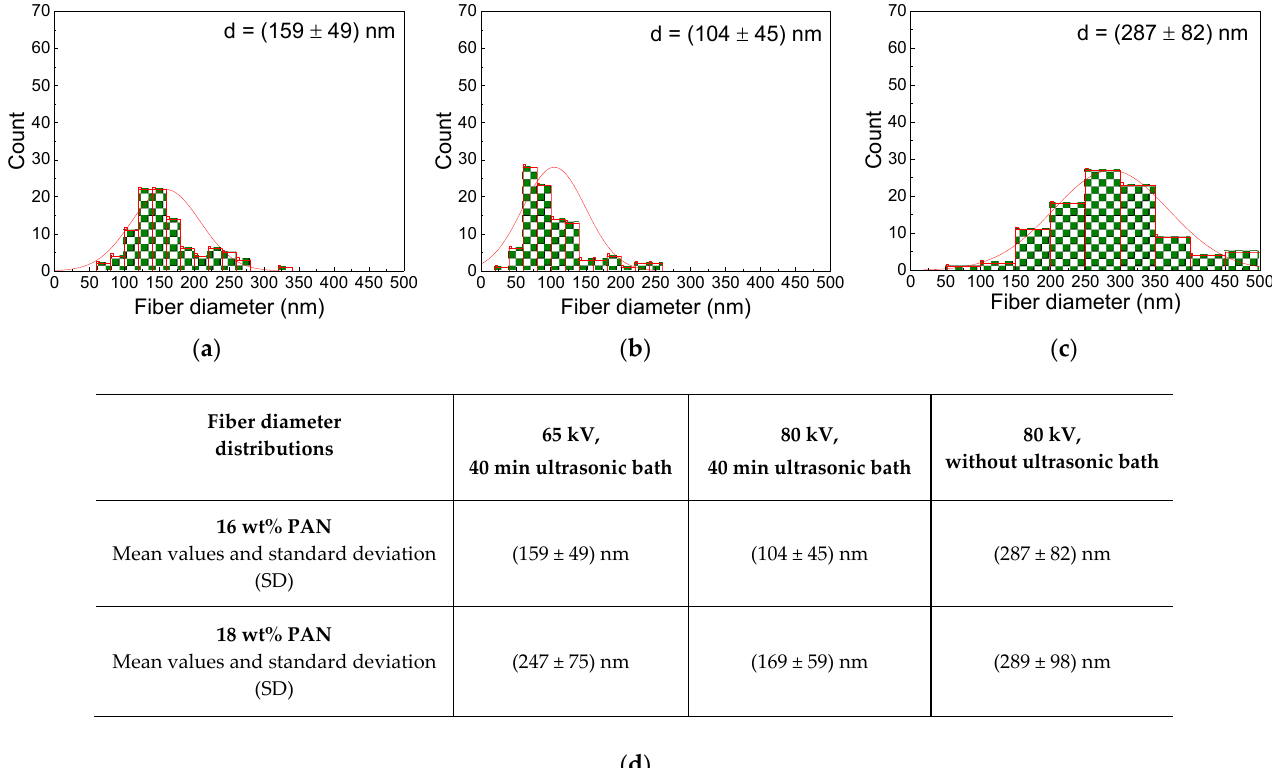
Figure 7. Diameter distributions of the magnetic nanofiber mats: ( a ) 16 wt% PAN with 65 kV voltage and 40 min ultrasonic bath; ( b ) 16 wt% PAN with 80 kV voltage and 40 min ultrasonic bath; ( c ) 16 wt% PAN and 80 kV voltage without ultrasonic bath; ( d ) Fiber diameter distributions of nanofiber mats from 16 wt% PAN and 18 wt% PAN.